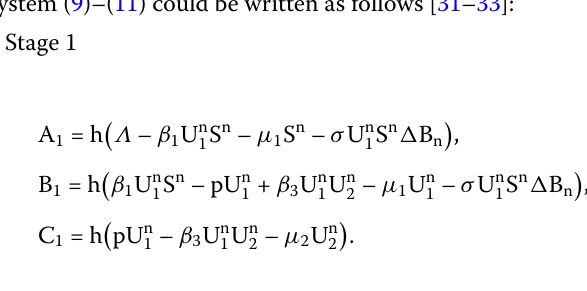
where “h” is represented as a time step size and (cid:6) B n ∼ N(0,1). The solution of system (13) is illustrated in Fig.